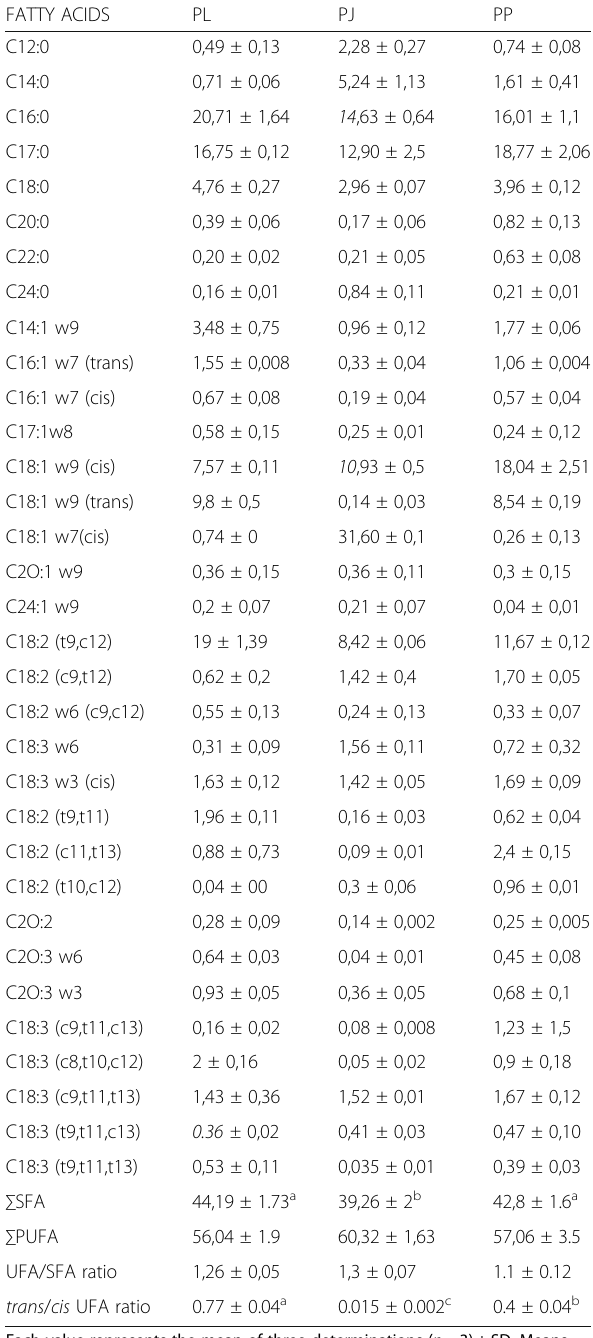
Each value represents the mean of three determinations ( n =3)±SD. Means with different letters within the same row column were significantly different at the level of p